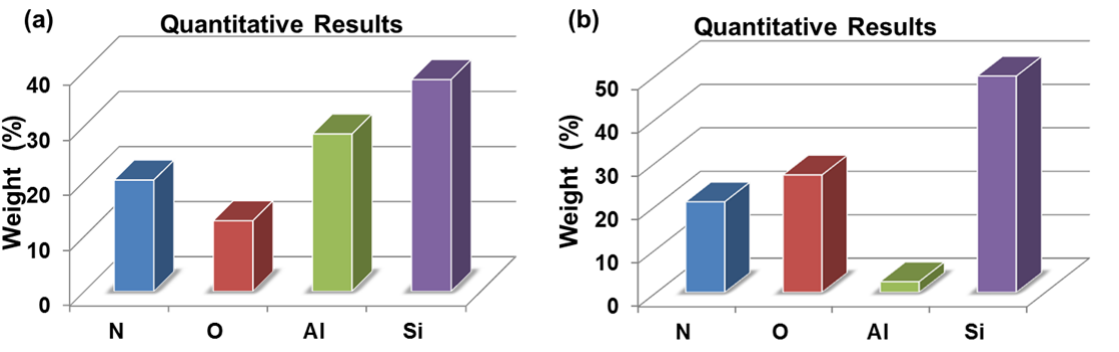
Figure 10. Results of the molecular weight of the materials placed on the surface areas of the pMEA, which were obtained (a) before and (b) after of the CMOS